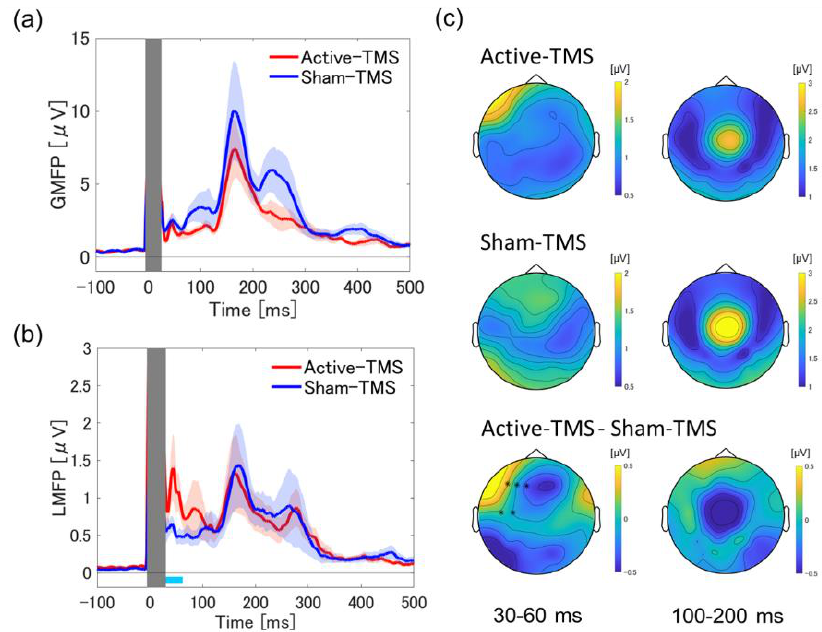
Figure 1. Averaged GMFP for all participants and averaged LMFP at the DLPFC stimulation site. ( a ) The upper-left panel shows the averaged GMFP waveforms (mean ± S.E.) of the TEP for all participants under active and sham conditions (active stimulation is shown as red waveform and sham stimulation is shown as blue waveform). ( b ) Likewise, the lower-left panel shows the aver- aged LMFP waveforms (mean ± S.E.) of the TEP for all participants confined to the DLPFC stimula- tion site electrodes (F3, F5, F1, F7, and AF3) (active stimulation is shown as red waveform, sham stimulation is shown as blue waveform). The light-blue bars below each graph on the left side indi- cate the time intervals where the statistical test showed a significant difference between the two conditions (30 – 60 ms). ( c ) The figure on the right shows the topoplots corresponding to the time intervals for the early component (30 – 60 ms) and the late component (100 – 200 ms) (top: active con- dition; middle: sham condition; bottom: active condition – sham condition). The electrode sites that showed significant differences between the two conditions were marked with a black asterisk. S.E.: standard error. 3.2. Graph Theory-Based Network Analyses Using wPLI Values There was no significant group difference in the total power analysis for the TEP with single-pulse TMS to the DLPFC between the active and sham conditions. On the other hand, ITPC analysis for the TEP after single-pulse TMS to the DLPFC showed a signifi- cantly higher phase synchronization (p corrected = 0.032) in the active condition compared with the sham condition in θ - and β -bands in the time interval of approximately 30 – 200 ms post-stimulation (see Figure 2c).